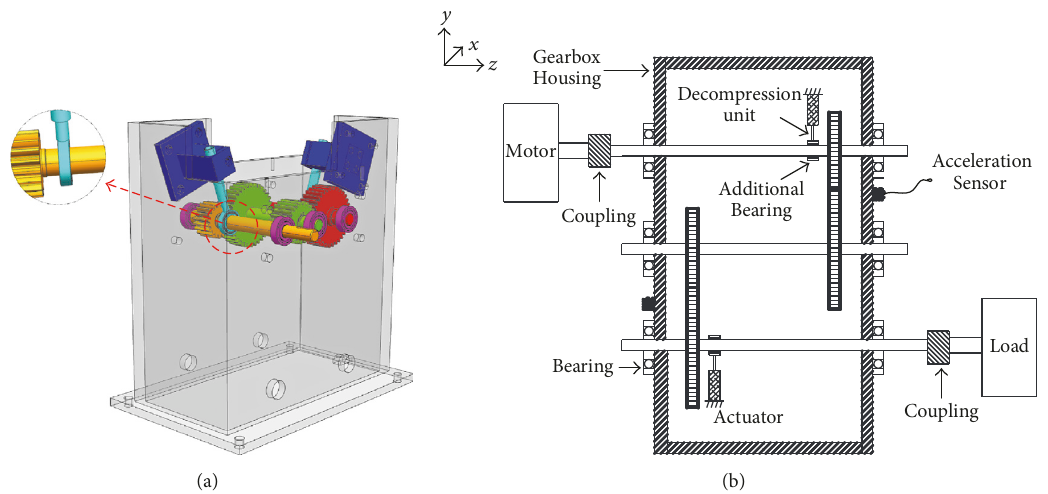
Figure 5: The three-dimension and cross-sectional view of MGTS.